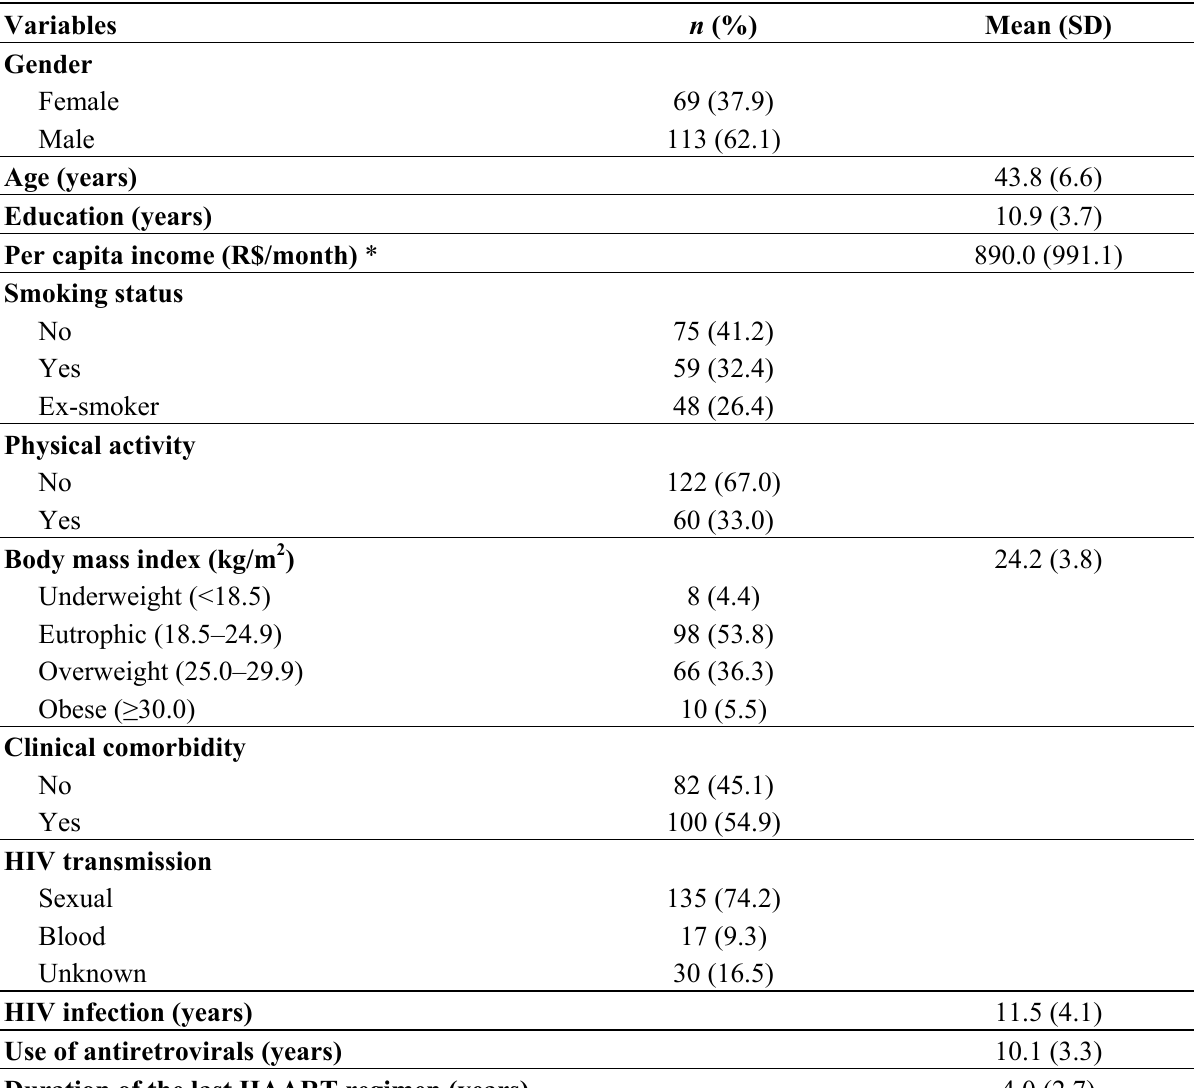
Table 1. Characteristics of the study population ( n =